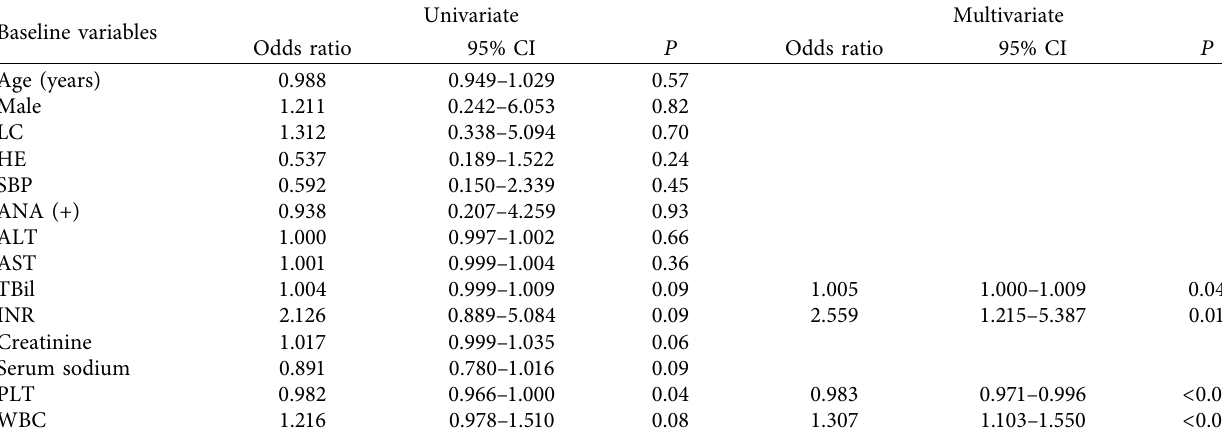
Table 2: Risk factors for 90-day mortality in patients with